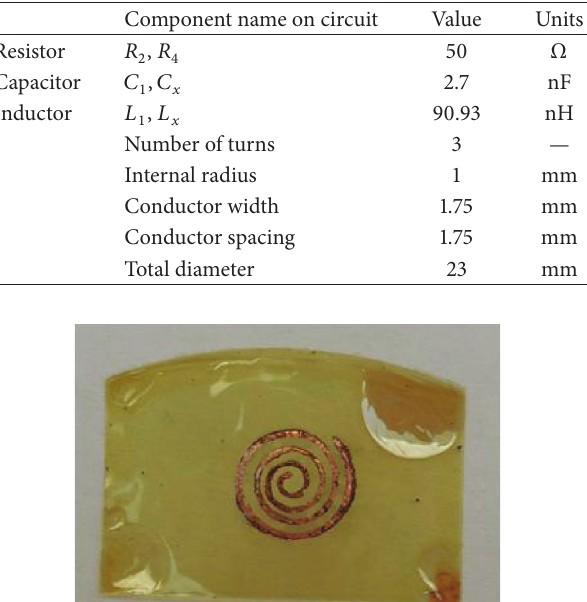
Table 1: Values of the components from the Maxwell-Wien bridge circuit.